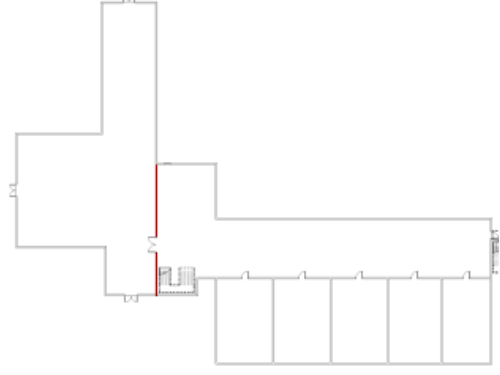
Figure 4: Highlighted (red) part of the wall is considered as exterior wall